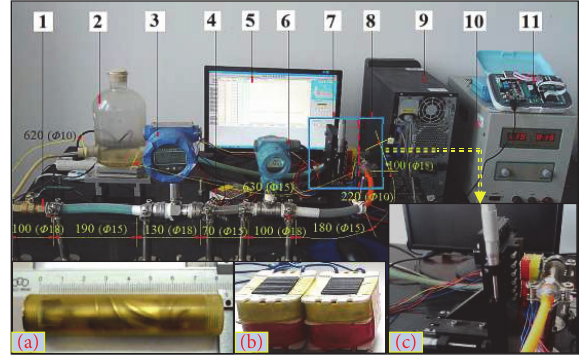
Figure 10: Experiment Device. 1: damping valve; 2: water reservoir; 3: eddy flow sensor; 4: 12 V switching power supply; 5: monitoring system; 6: pressure transmitter; 7: electromagnet and mobile plat- form; 8: axial-flow blood pump; 9: PC; 10: DC power source; 11: SCM control system.